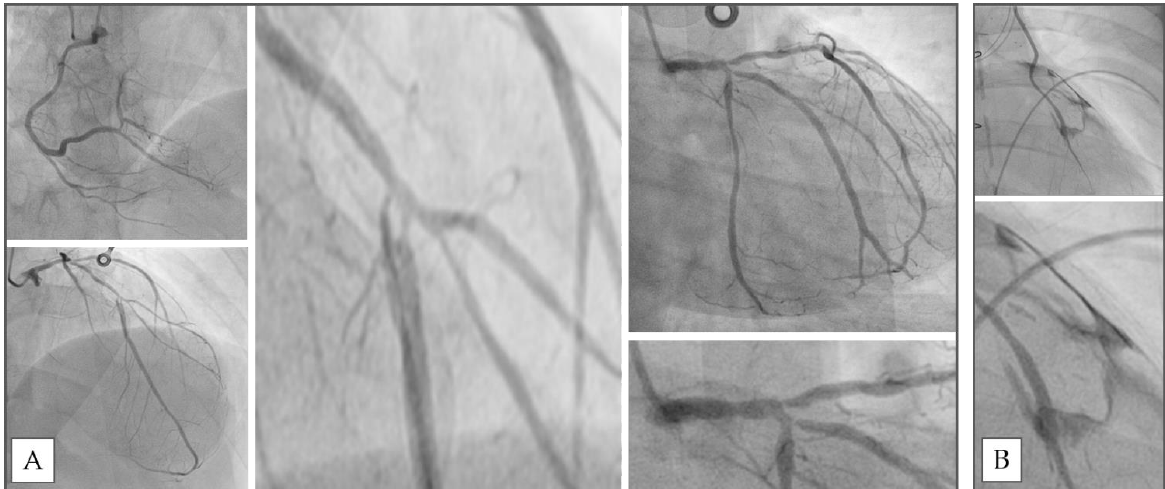
Figure 2. Coronary angiography. ( A ): Multivessel disease on admission. ( B ): Detachment of radial graft with pericardial blush of contrast medium.